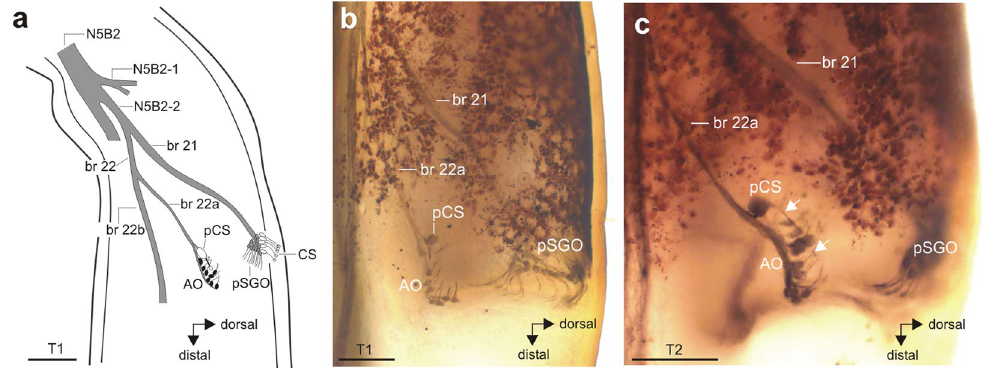
Figure 6. The structure and innervation of the accessory organ (AO). ( a ) Schematic of the AO and its innervation by the nerve N5B2. Different nerve branches are numbered consecutively from the proximal direction. Sensilla in the AO are shown in black, sensilla in the SGO in grey, and campaniform sensilla are shown in white. The AO shows similar organisation in ( b ) foreleg T1 and ( c ) midleg T2. The scolopidial sensilla of the accessory organ are always associated with a single posterior campaniform sensillum (pCS), the long dendrite of the pCS is indicated by two white arrows in ( c ). Note that AO dendrites point in proximal or proximo-dorsal direction. Abbreviations: AO, accessory organ; CS, dorsal campaniform sensilla; pCS, posterior campaniform sensillum; pSGO, posterior subgenual organ. Scales: ( a , b ) = 100 µ m; ( c ) = 200 µ